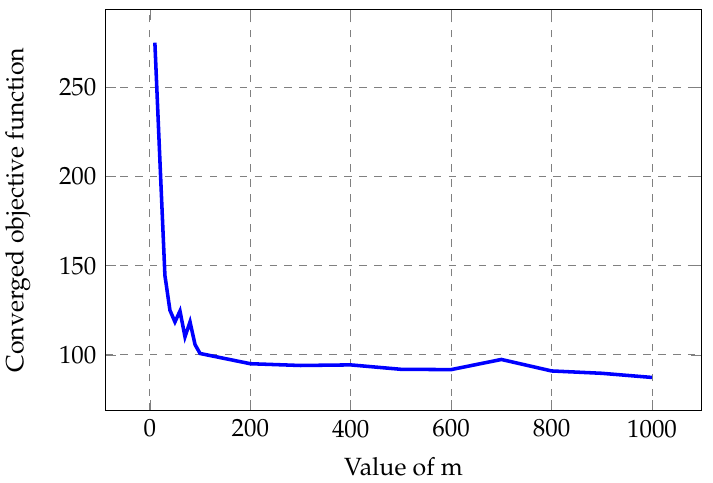
Figure 7. SA converged objective function value versus value of m for the MBB beam problem with a 0.5-volume fraction ( m is the number of objective function evaluations to reach thermal equilibrium in a specific temperature).